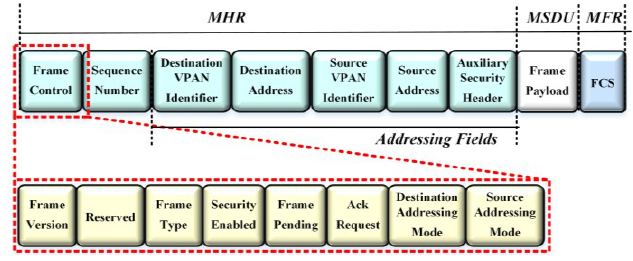
Figure 6. MAC frame structure that used this work, reproduced from